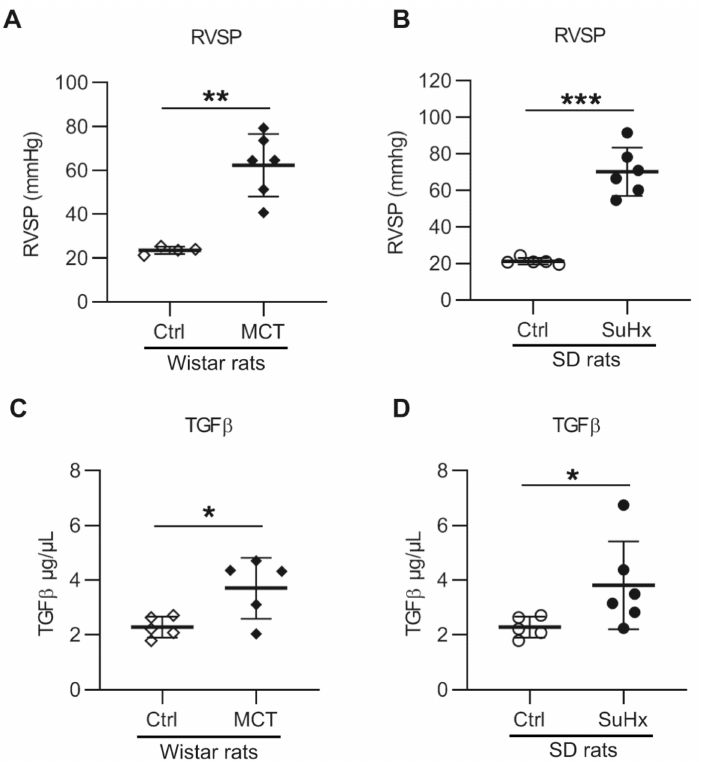
Figure 1. Right ventricle (RV) systolic pressure and serum transforming growth factor- β 1 (TGF- β 1) levels in animal models with pulmonary arterial hypertension: ( A ) RV systolic pressure (RVSP) in monocrotaline (MCT) rats. n(Ctrl) = 4, n(MCT) = 6; ( B ) RVSP in sugen–hypoxia (SuHx) rats. n(Ctrl) = 5, n(SuHx) = 6; ( C ) serum TGF- β 1 level in MCT rats. n(Ctrl) = 5, n(MCT) = 5; ( D ) serum TGF- β 1 level in SuHx rats. n(Ctrl) = 5, n(SuHx) = 6. * p < 0.05, ** p < 0.01, *** p < 0.001.